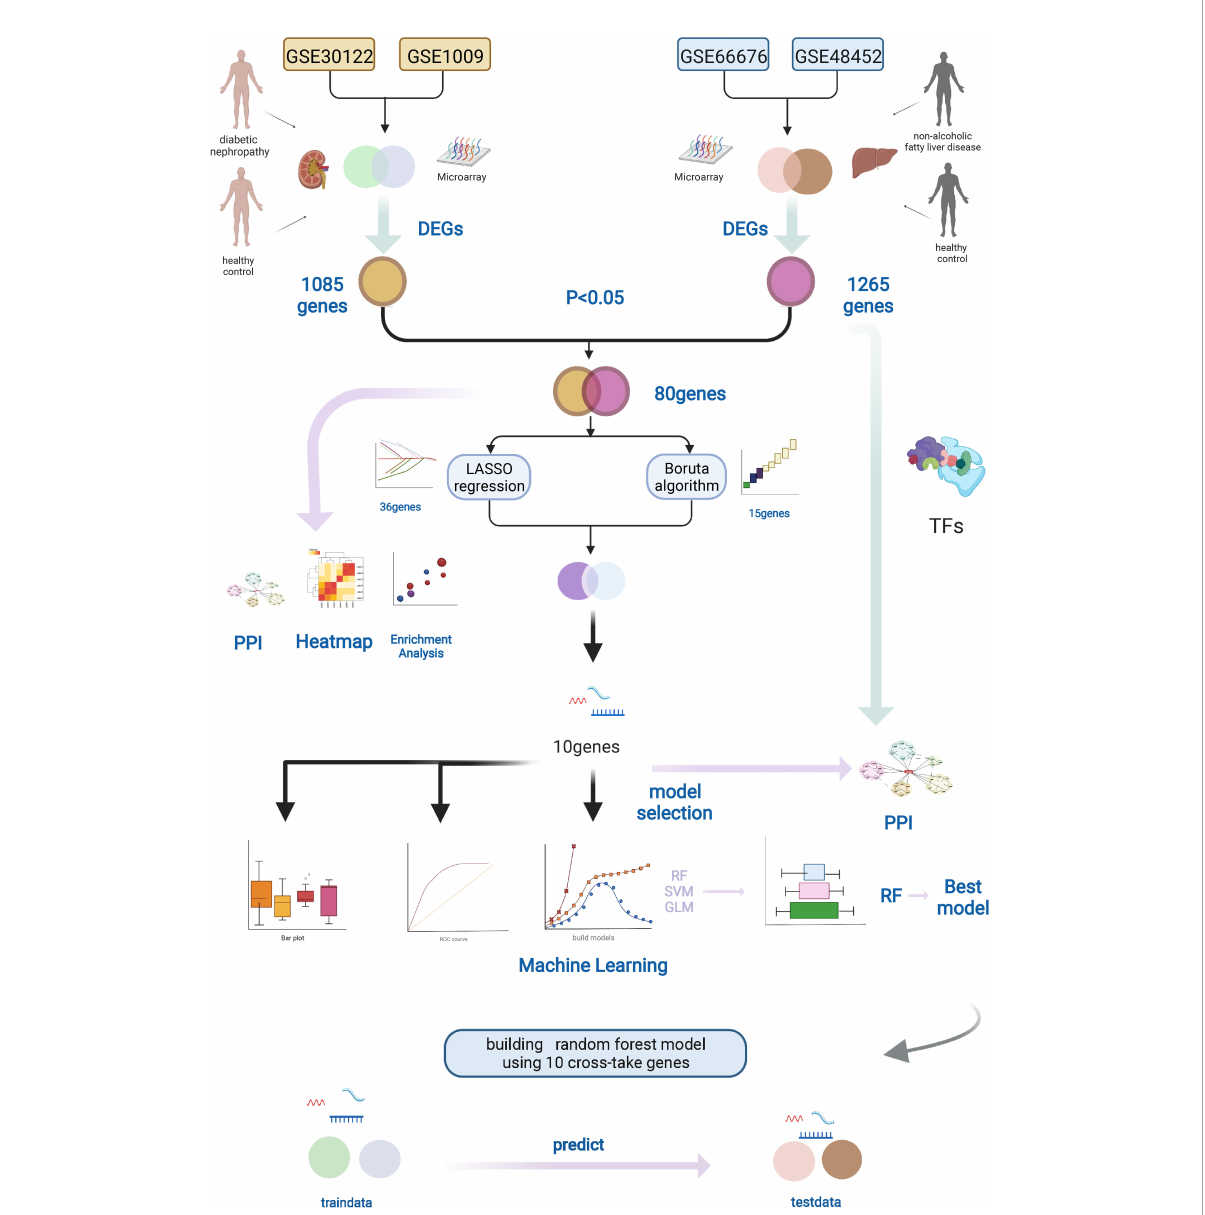
FIGURE 1 Work fl ow of this study. We downloaded the gene expression pro fi les of NAFLD and DN from the GEO database, including two NAFLD datasets (GSE66676 and GSE48452) and two DN datasets (GSE30122 and GSE1009). Datasets were merged, and DEGs were found by R software. The LASSO regression and Boruta algorithm were used to select the optional crosstalk genes. RF model was considered the best model to predict DN using the 10 crosstalk genes. In addition, protein – protein interaction (PPI) and functional enrichment analyses of the DEGs were performed. Graphic created with BioRender.com. NAFLD, nonalcoholic fatty liver disease; DN, diabetic nephropathy; GEO, Gene Expression Omnibus, DEGs, different expression